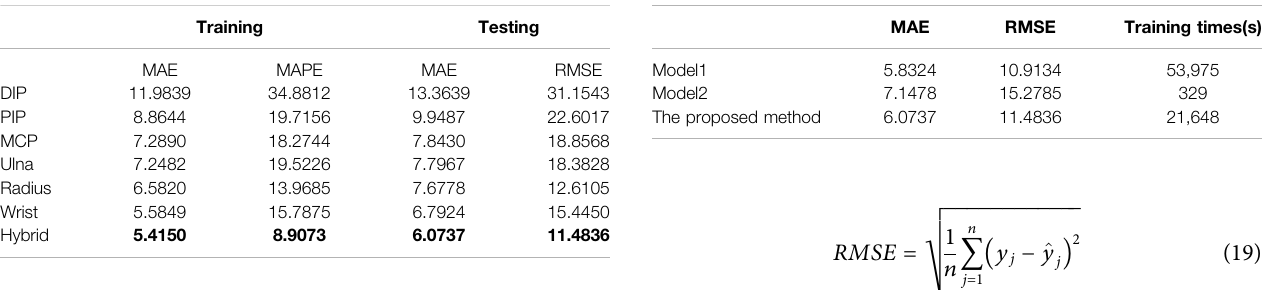
TABLE 3 | Comparison analysis on performance of different